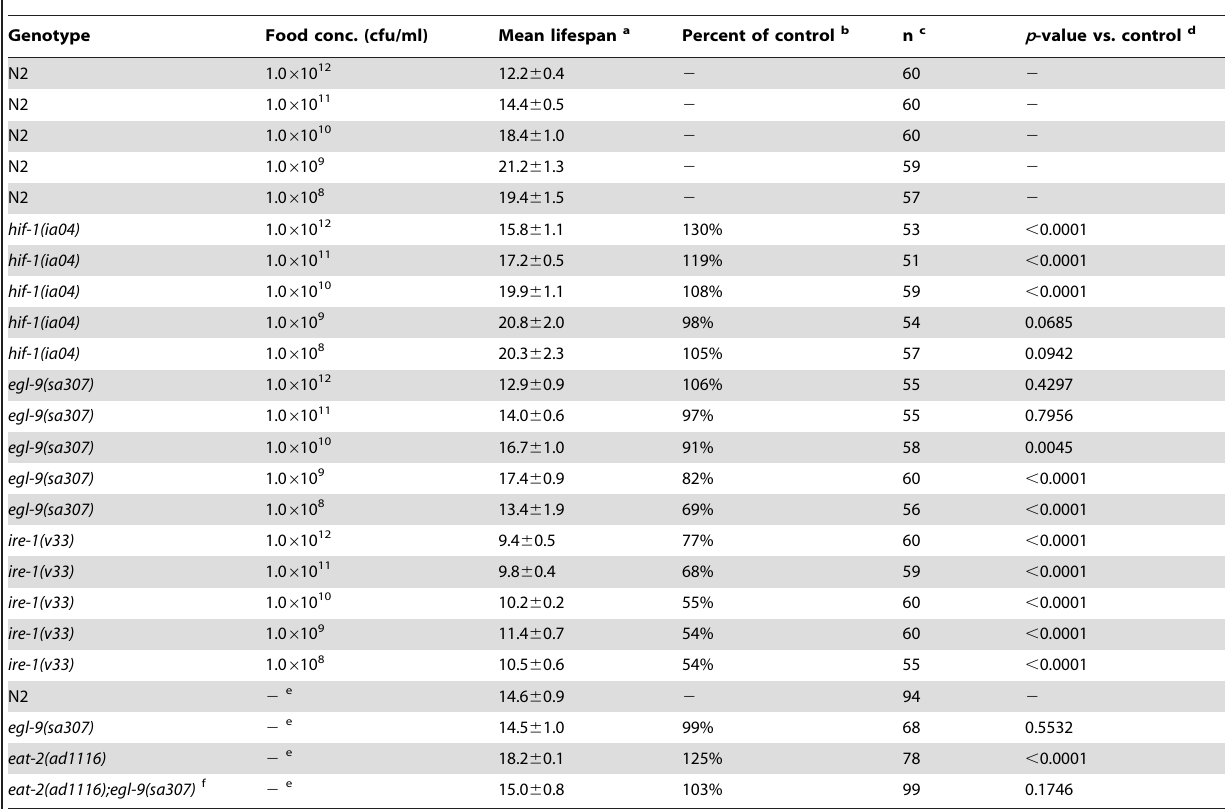
Table 2. HIF-1 and IRE-1 modulate lifespan extension by DR.